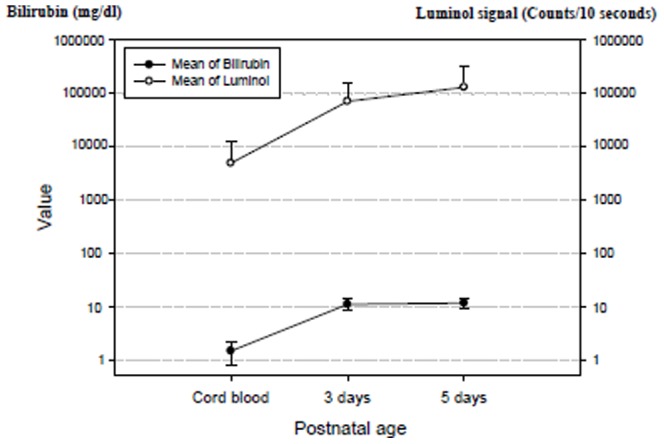
Bilirubin concentrations and hydrogen peroxide levels increased similarly during the first few days.The correlation between these two variables was 0.454, P<0.001. The left y-axis is the bilirubin concentration, whereas the right y-axis is the H2O2 (luminol) signal. The y-axis scale is logarithmic because of the high luminal signal values.